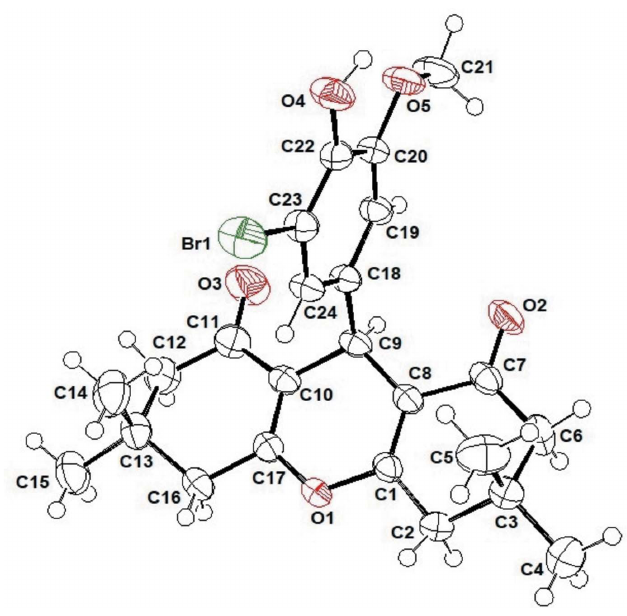
Figure 1 A view of the structure of (I), showing the atom-numbering scheme. Displacement ellipsoids are drawn at the 50% probability